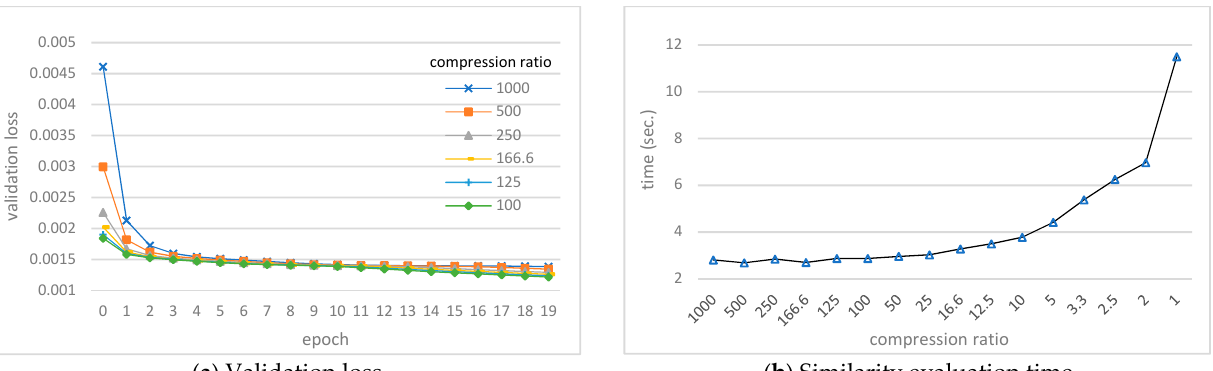
Figure 5. Experiments for the number of nodes in the latent representation layer of the DAE.